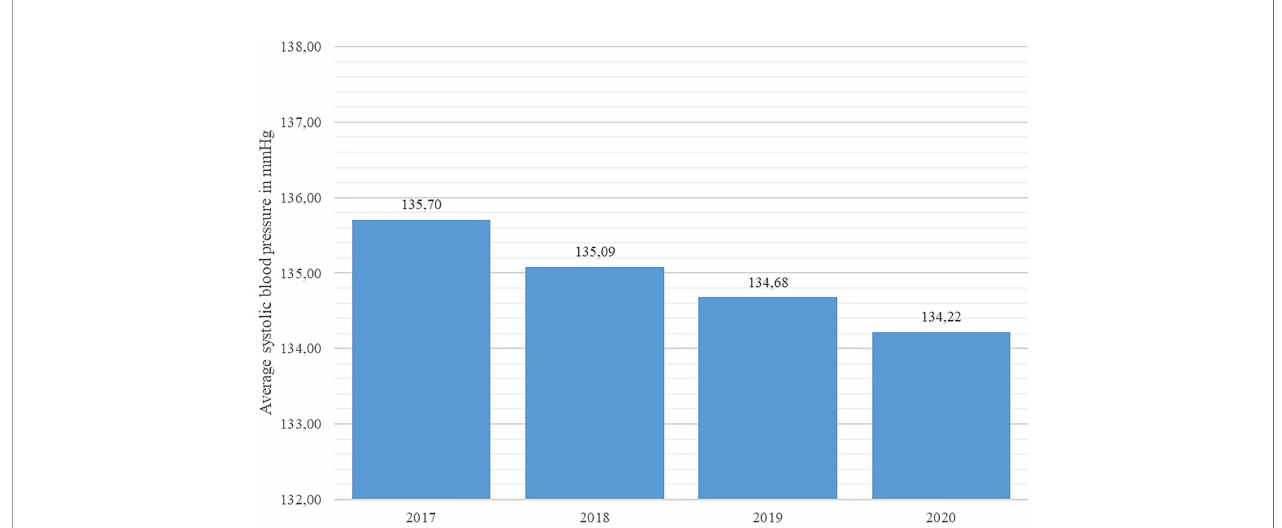
FIGURE 4 | Average systolic blood pressure values in diabetes patients in Croatia per year, 2017 -